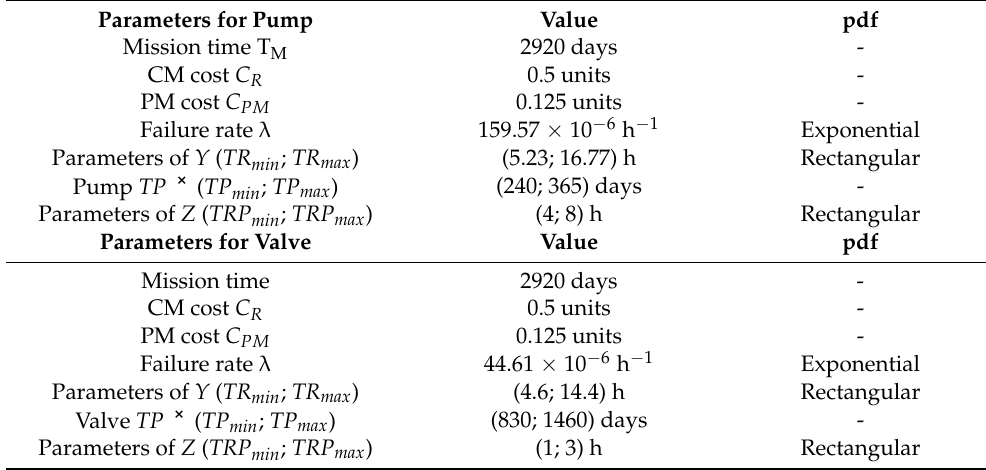
Table 1. Reliability and cost data for system components.